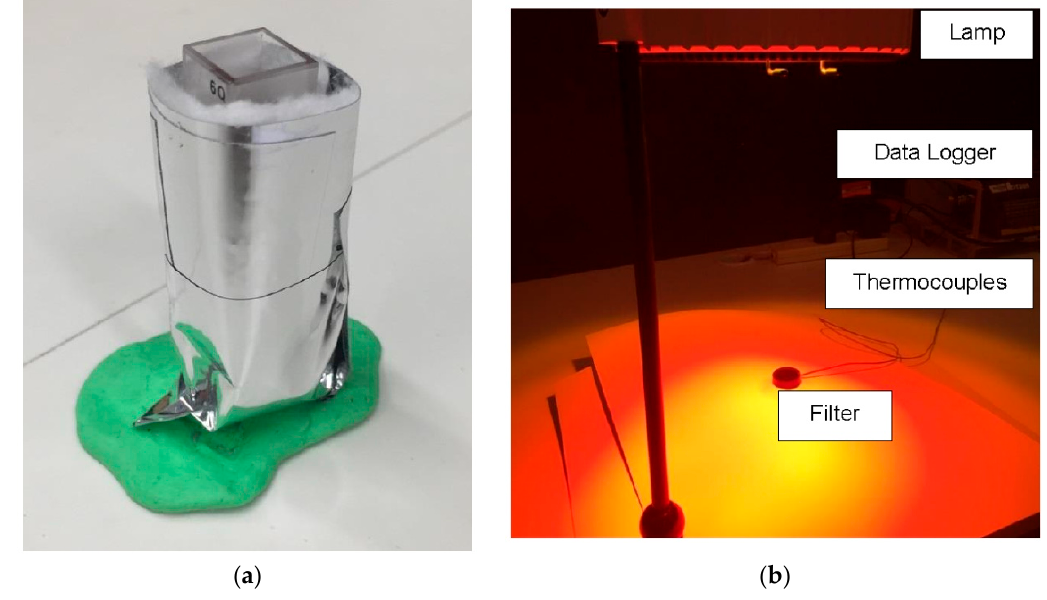
Figure 2. ( a ) The GNR solution sample was wrapped by insulation and reflective material and ( b ) Equipment set-up of the thermal